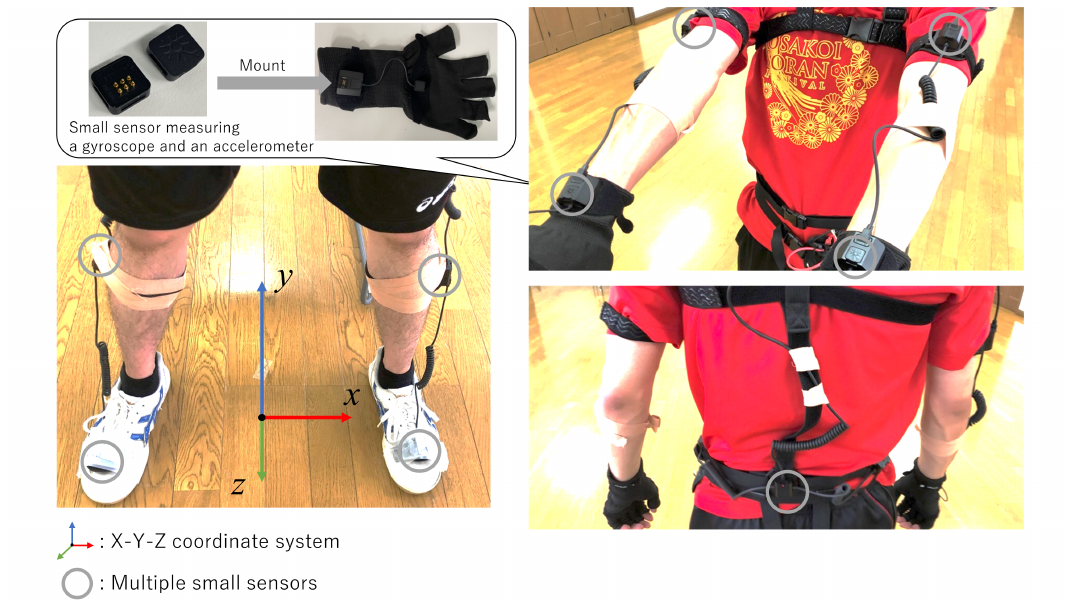
Figure 3. Attachment of PN to the performer is presented with 18 small sensors at hand, arm, shoulder, leg, head, and waist that measure inertia, such as a gyroscope and an accelerometer. The relative positions among the sensors are measured, and the 3D positions of the sensors are